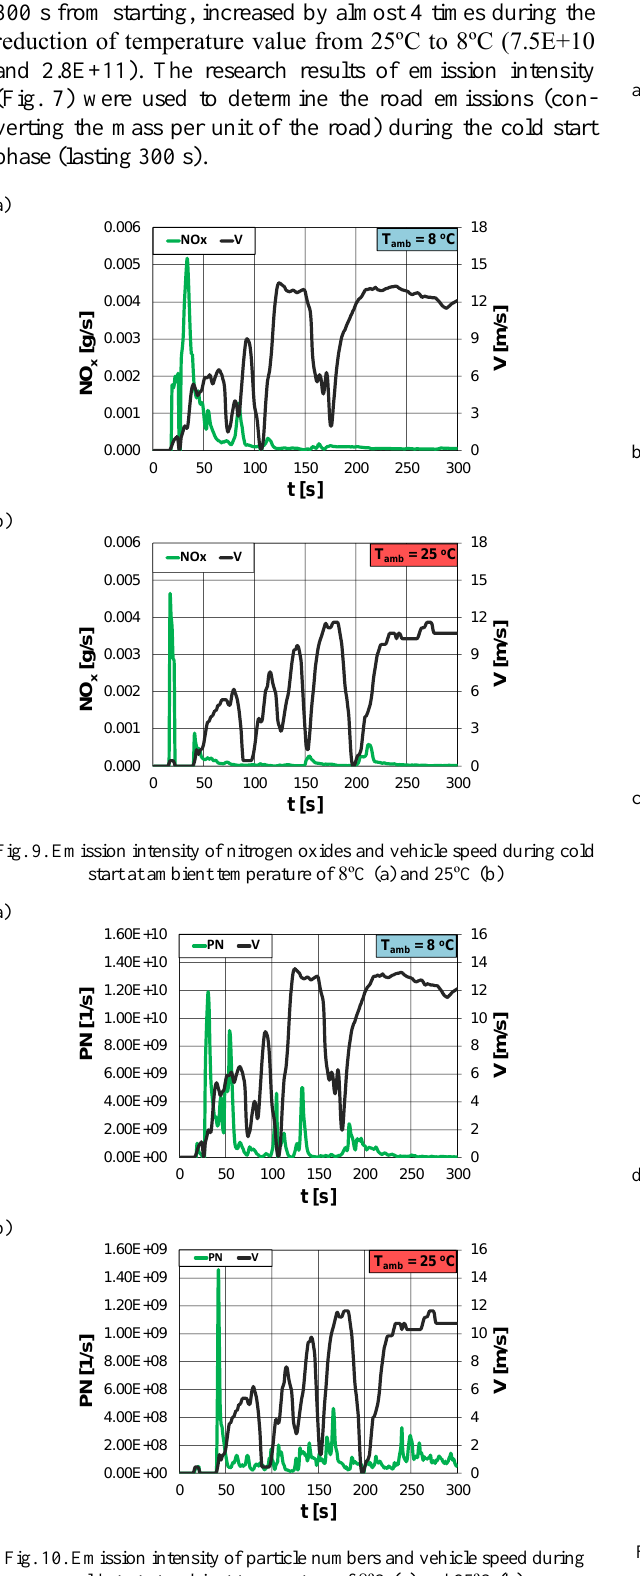
Fig. 10. Emission intensity of particle numbers and vehicle speed during cold start at ambient temperature of 8ºC (a) and 25ºC (b)